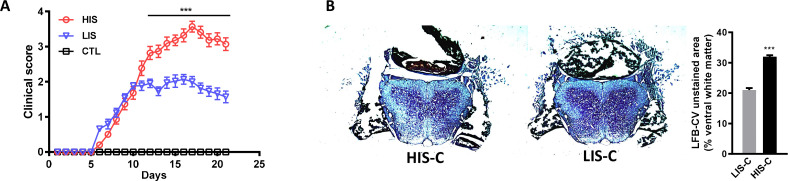
Spinal cord lesions are more pronounced in mice with high clinical score (HIS) compared to mice with low clinical score (LIS).(A) Clinical score of a mouse cohort showing EAE mice with high clinical score (HIS) or low clinical score (LIS) receiving an injection of cytokine (-C) at day 21 post-immunization. (B) Representative photomicrographs of LFB staining (with cresyl violet counterstaining) performed on the spinal cord of HIS-C and LIS-C mice. (C) Representative photomicrographs of MBP immunofluorescence in the spinal cord of HIS-C and LIS-C mice of the same cohort. N = 9/group. Data are mean ± sem. For A, two-way ANOVA with Sidak’s post-hoc test, vs LIS ***p≤0.001. For B, two-tailed t test, ***p≤0.001.